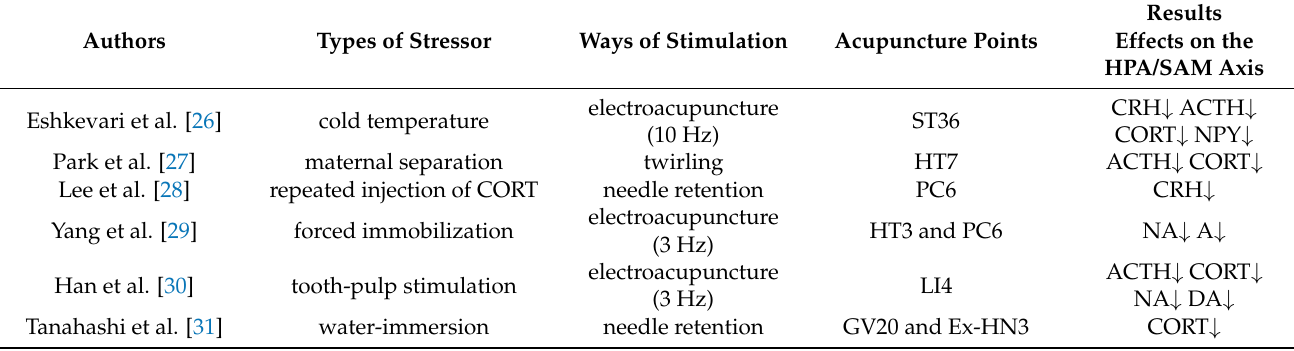
Table 1. Acupuncture treatments for rodent stress models.